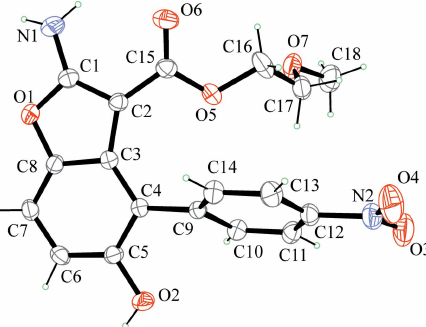
Figure 3 Molecular structure of BF2 with displacement ellipsoids drawn at the 30% probability level.